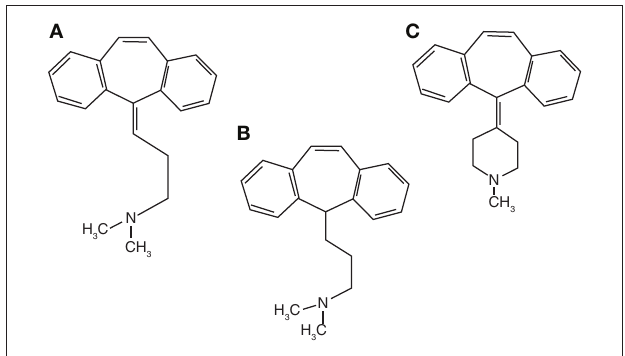
Figure 3 | Chemical structures of cyclobenzaprine (A), amitriptyline (B), and cyproheptadine